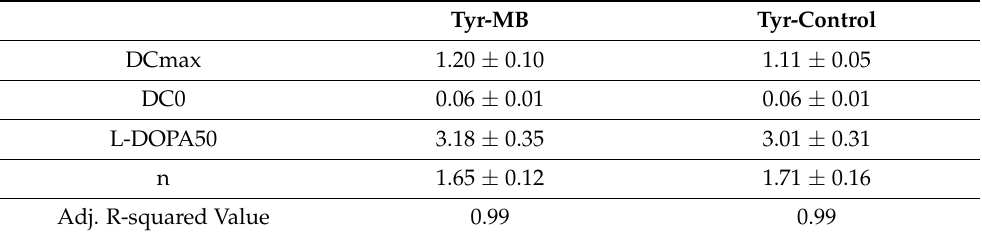
Table 1. Parameters of the Hill dose-response equation for Tyr-MB compared to the values for dopachrome production in the Tyrosinase